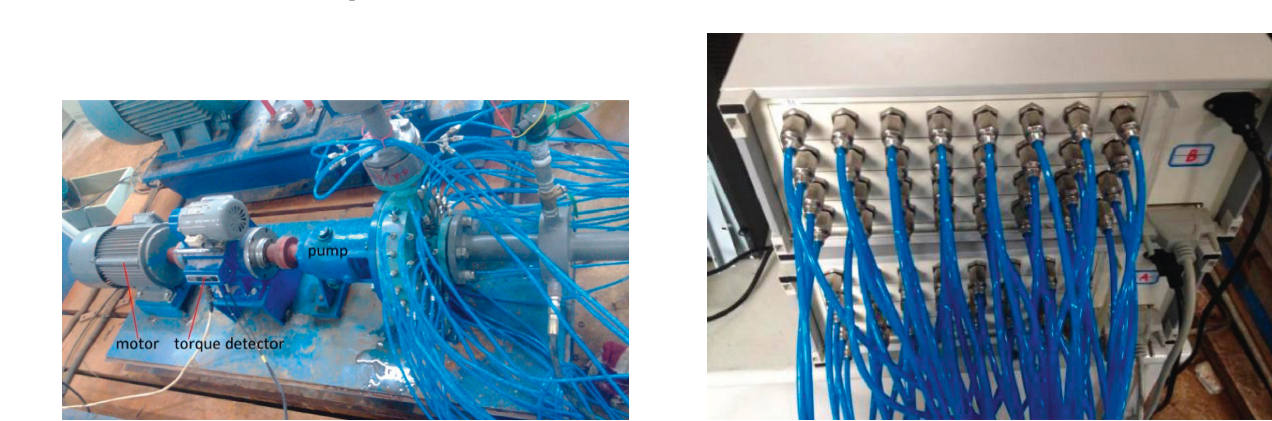
Figure 2: Tip clearance.